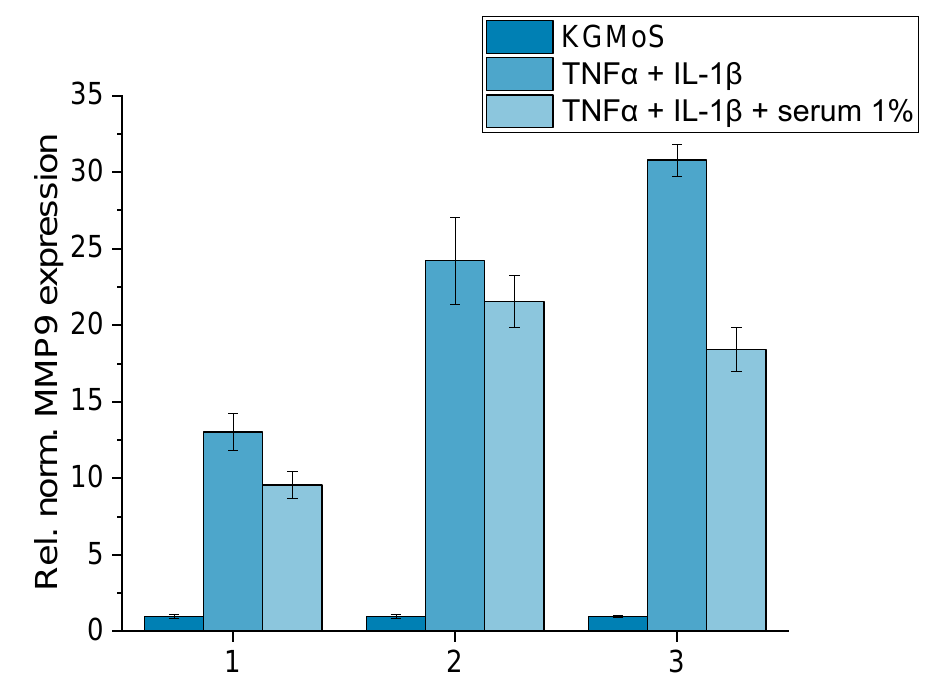
Figure 10. HCE-T cells were cultivated with TNF α (10 ng/mL) and IL-1 β (10 ng/mL) for 72 h; serum was added under dynamic conditions in the Ocular DynaMiTES system with a turnover rate of 8.3% and a flow rate of 75 µL/min for 180 min; gene expression of MMP9 is depicted; the numbers 1–3 on the abscissa depict three independent experiments with 1 well per sample (n well = 1) and 2–3 technical replicates per well (n technical replicate = 2–3); mean ± SD of technical